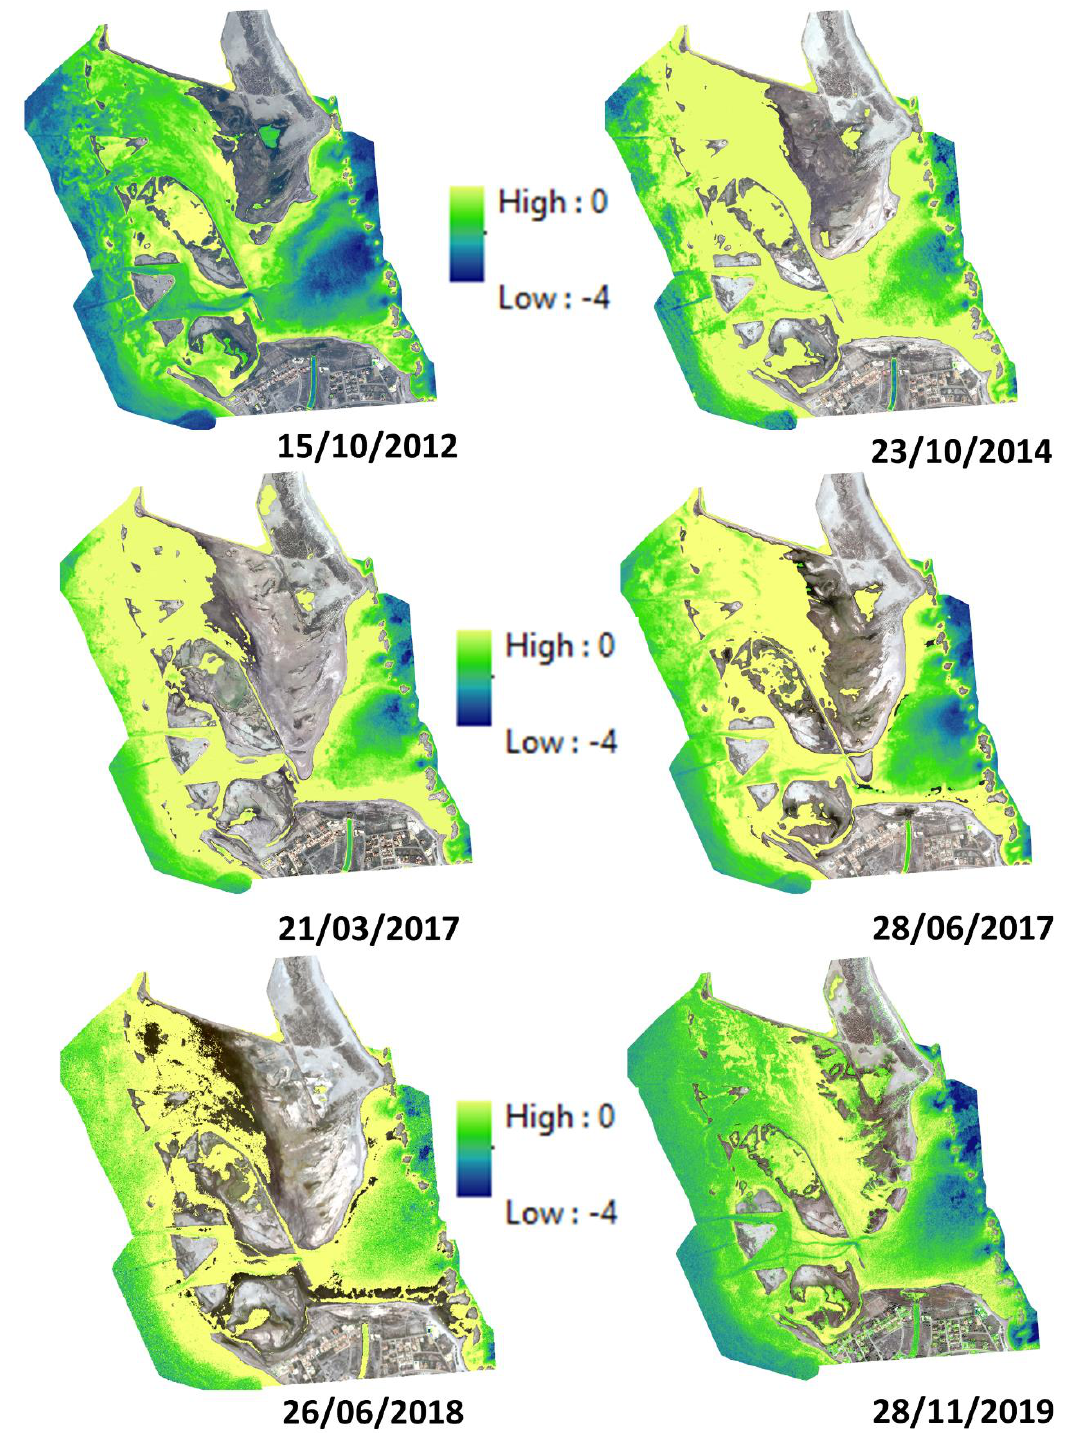
Figure A2. Bathymetry time series using Pleiades images between 15 October 2012 and 28 November 2019.